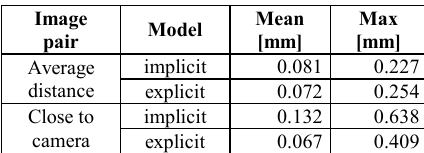
Table 7. 3D error of 3D points calculated from two image pairs.